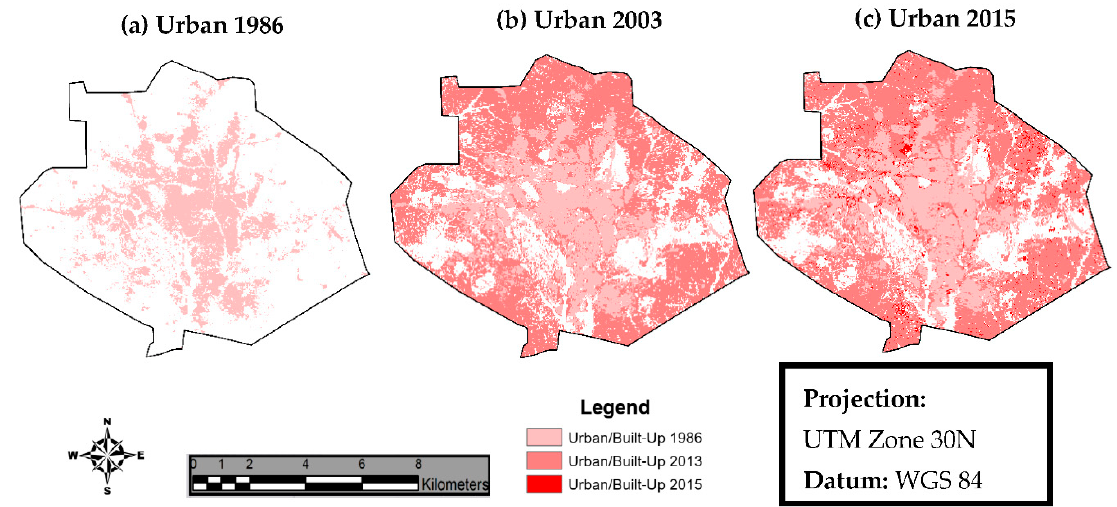
Figure 7. Urban expansion in Kumasi.